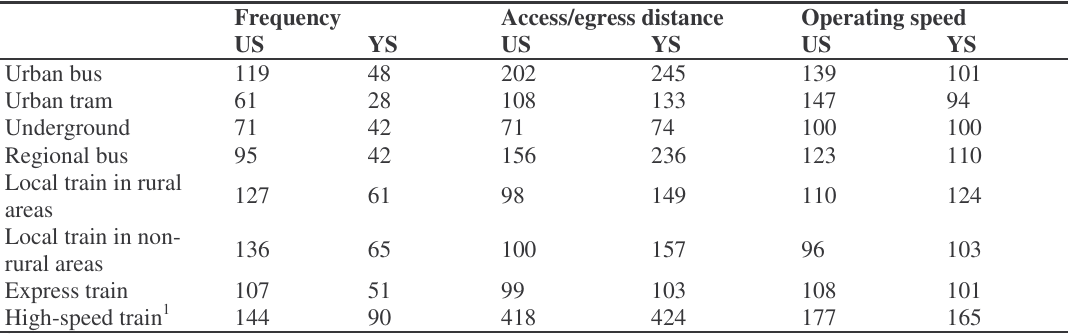
Table 8. Level of service impacts of two scenarios (1990 = 100) Frequency Access/egress distance Operating speed